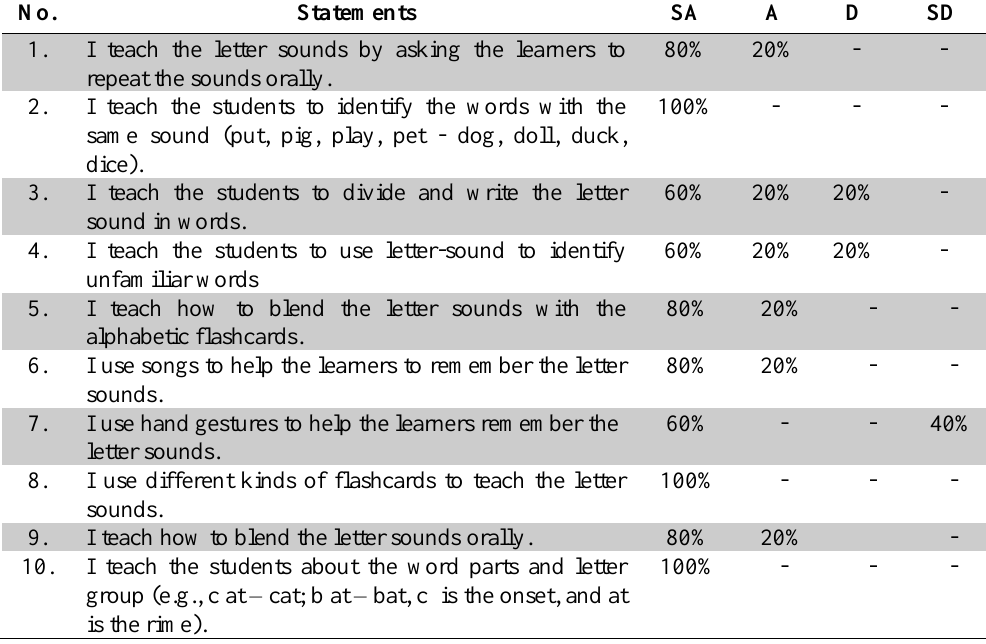
Table 1. Results of the Closed-ended Questionnaire on the Process of Implementing Effective Techniques of Teaching Phonics